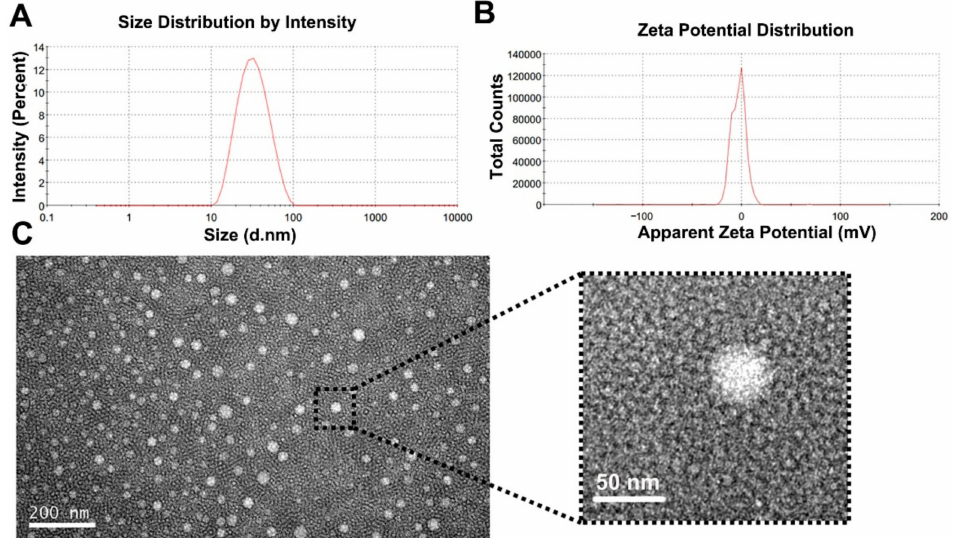
Figure 3. Characterization of the propofol-mixed micelles. ( A ) Size distribution, ( B ) zeta potential, and ( C ) representative TEM